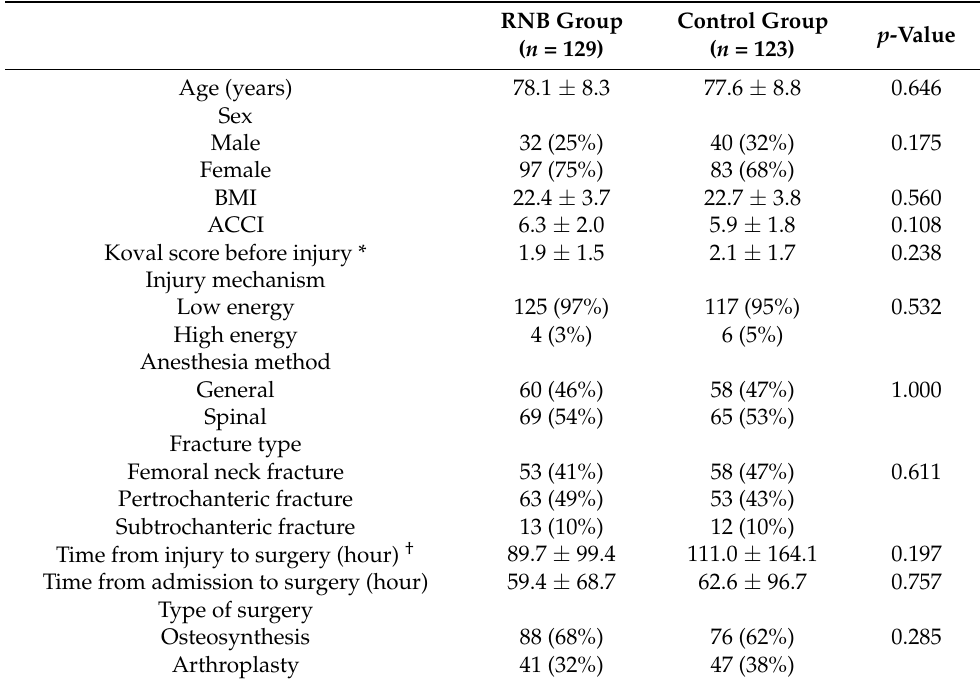
Table 1. Baseline characteristics of the RNB and control groups.